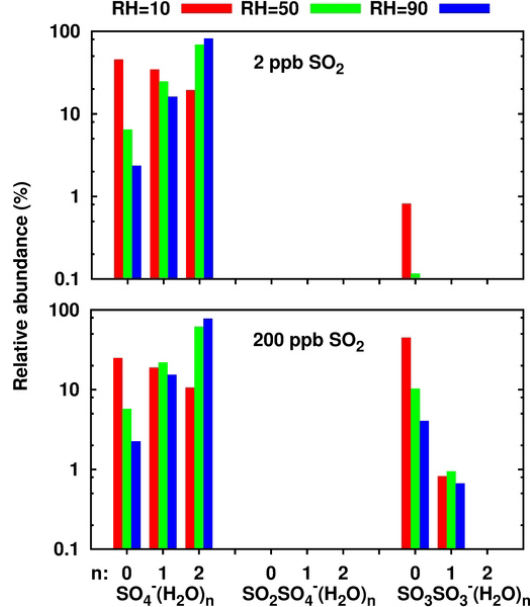
Figure 5. Distribution of the most stable anions in the reaction be- ( H 2 O ) n at thermal equilibrium. Concentrations tween SO 2 and SO − 4 are calculated for 2ppb and 200ppb of SO 2 and relative humidity RH = 10, 50, and 90%. The temperature is